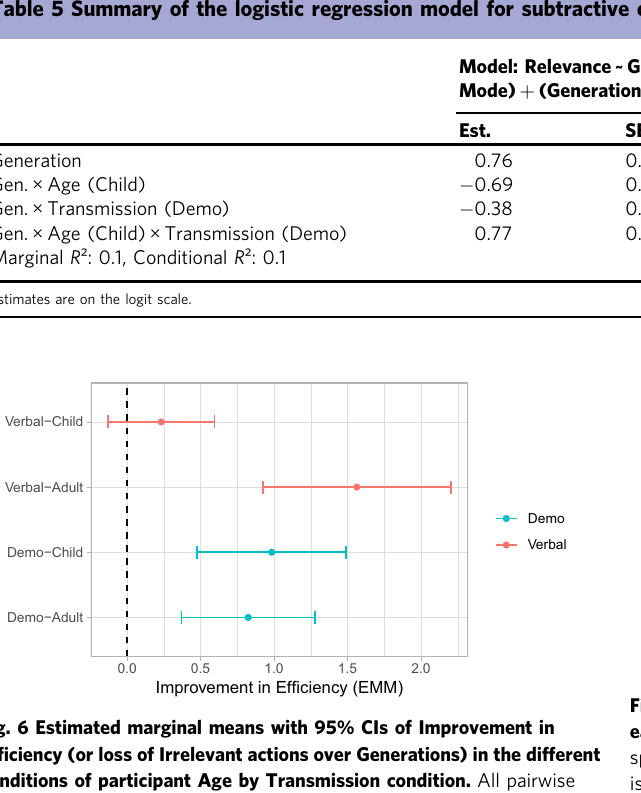
Table 4 Signi fi cant pairwise contrasts out of the 28 contrasts (see all contrasts in SM.5). Table 5 Summary of the logistic regression model for subtractive cumulative evolution.